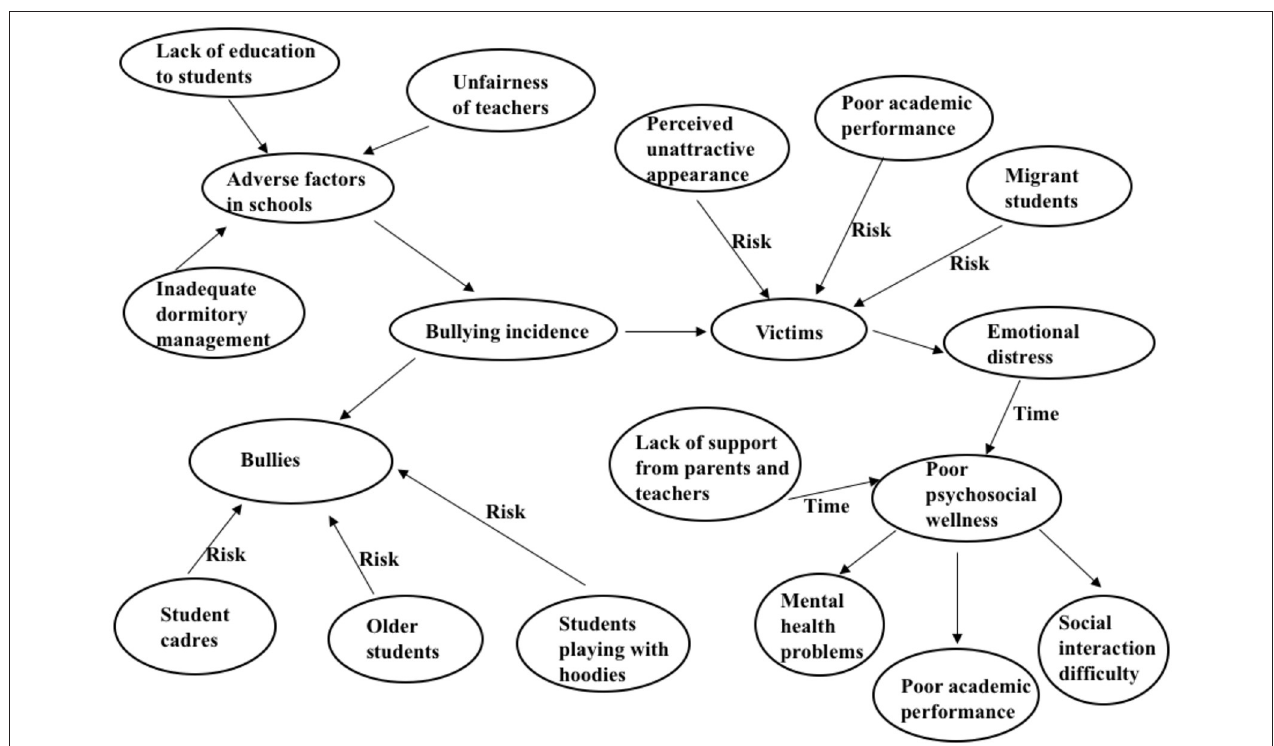
FIGURE 1 | Conceptual framework of the poor psychosocial well-being of bullying